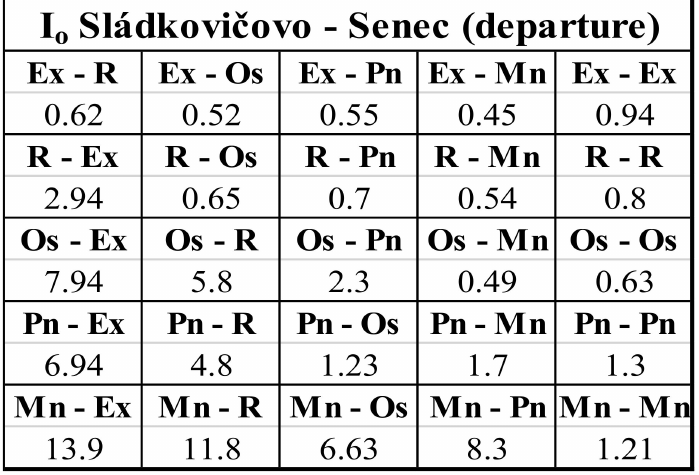
Figure 8. Resulting headway times (in minutes) for Sl á dkoviˇcovo railway station—direction from Senec station, ETCS L3.